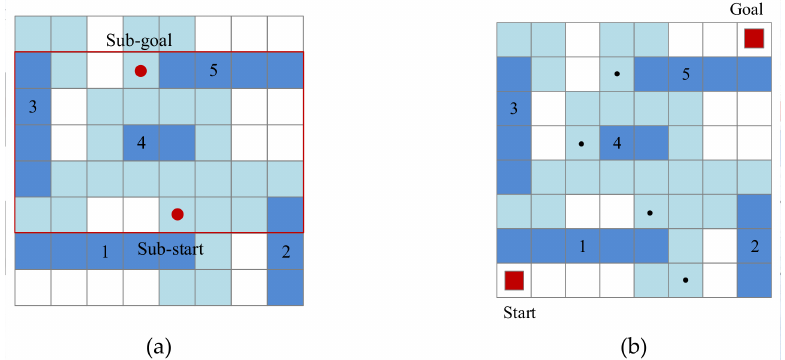
Figure 11. Selecting free cells to avoid obstacles. ( a ) A path from the selected free cell to the goal; ( b ) searching paths for the first free cell.